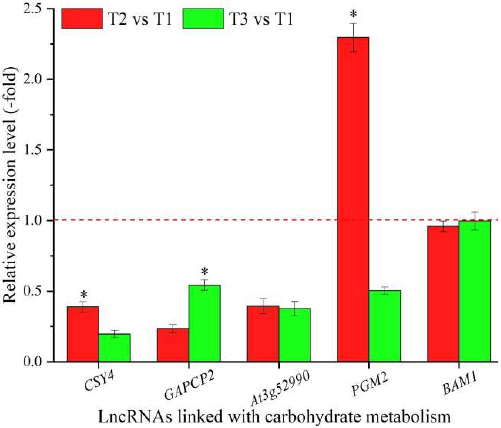
Figure 5. The expression levels of coexpressed mRNAs of lncRNAs linked with carbohydrate metabolism in A. sinensis at T2 vs. T1 and T3 vs. T1, as determined by qRT-PCR. The “*” represents a significant difference at p < 0.05 level between T2 vs. T1 and T3 vs. T2 for the same gene. 3.6. LncRNAs Linked with Biosignaling and Expression Levels of Their Coexpressed mRNAs tions of their coexpressed mRNAs, with 13 lncRNAs associated with hormone signaling, namely ARF1 , CUL1 , T4L20.330 , SOFL4 , SOFL5 , GRF2 , GRF11 , ERF3 , CIPK20 , SF1 , AGD9 ,